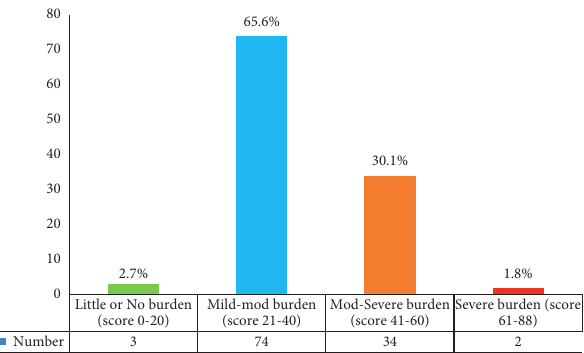
Figure 1: Level of care burden experienced by